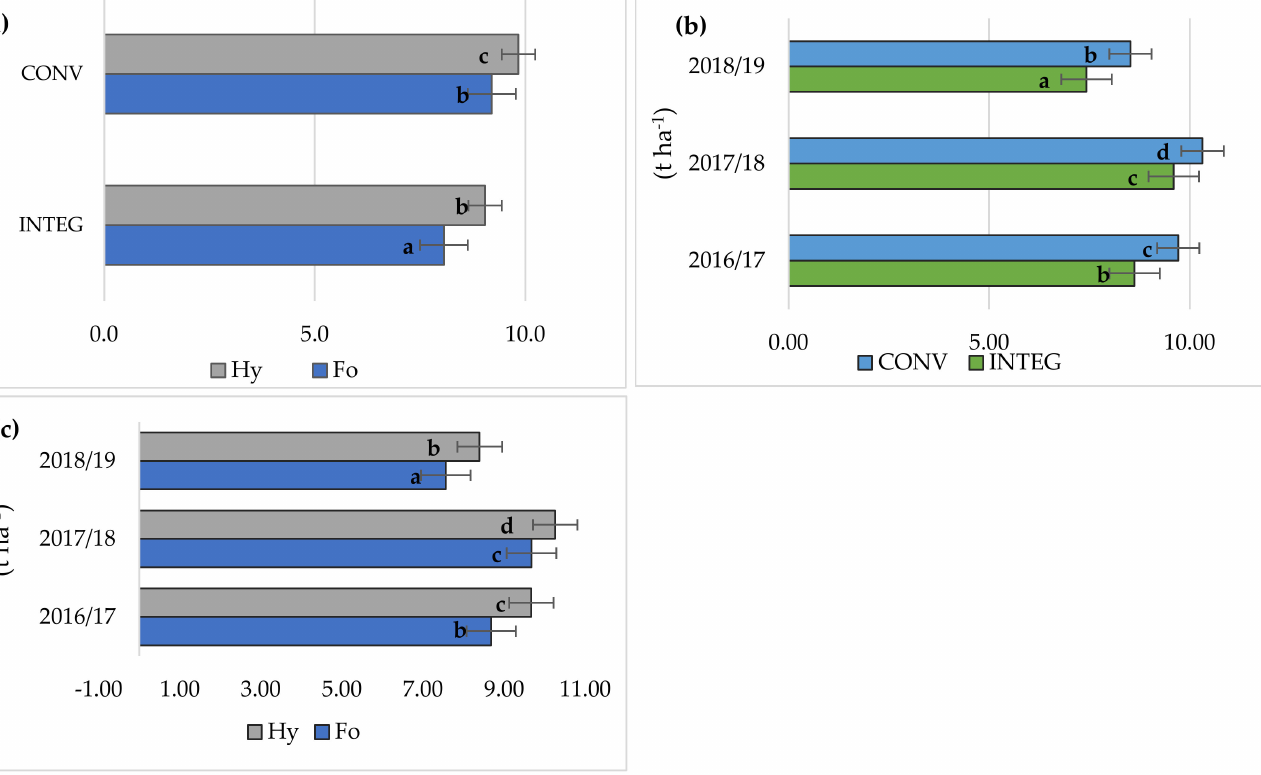
Figure 2. ( a – c ) Winter grain yield depending on ( a ) cultivars and cropping systems, ( b ) cropping sys- tems and years of research, and ( c ) cultivars and years of research. The presence of different lowercase letters indicates a statistical difference between means (Tukey’s Test, p = 0.05). INTEG—integrated cropping system, CONV—conventional cropping system, Fo—cv. Formacja, Hy—cv.